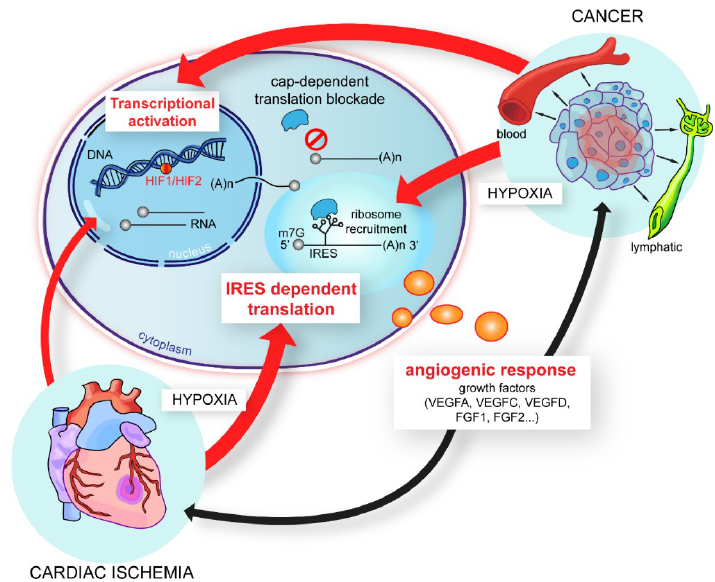
Figure 1. The regulation of the (lymph)angiogenic growth factor expression during hypoxia: (Lymph)angiogenic growth factors are regulated at the transcriptional and/or translational levels during hypoxia. In conditions of tumoral hypoxia, the regulation is both transcriptional and translational through the internal ribosome entry site (IRES)-dependent mechanism, whereas during cardiac ischemia in hypoxic cardiomyocytes, most regulation is translational [72]. The IRESs of (lymph)angiogenic growth factor mRNAs are activated during early hypoxia by an HIF1- independent